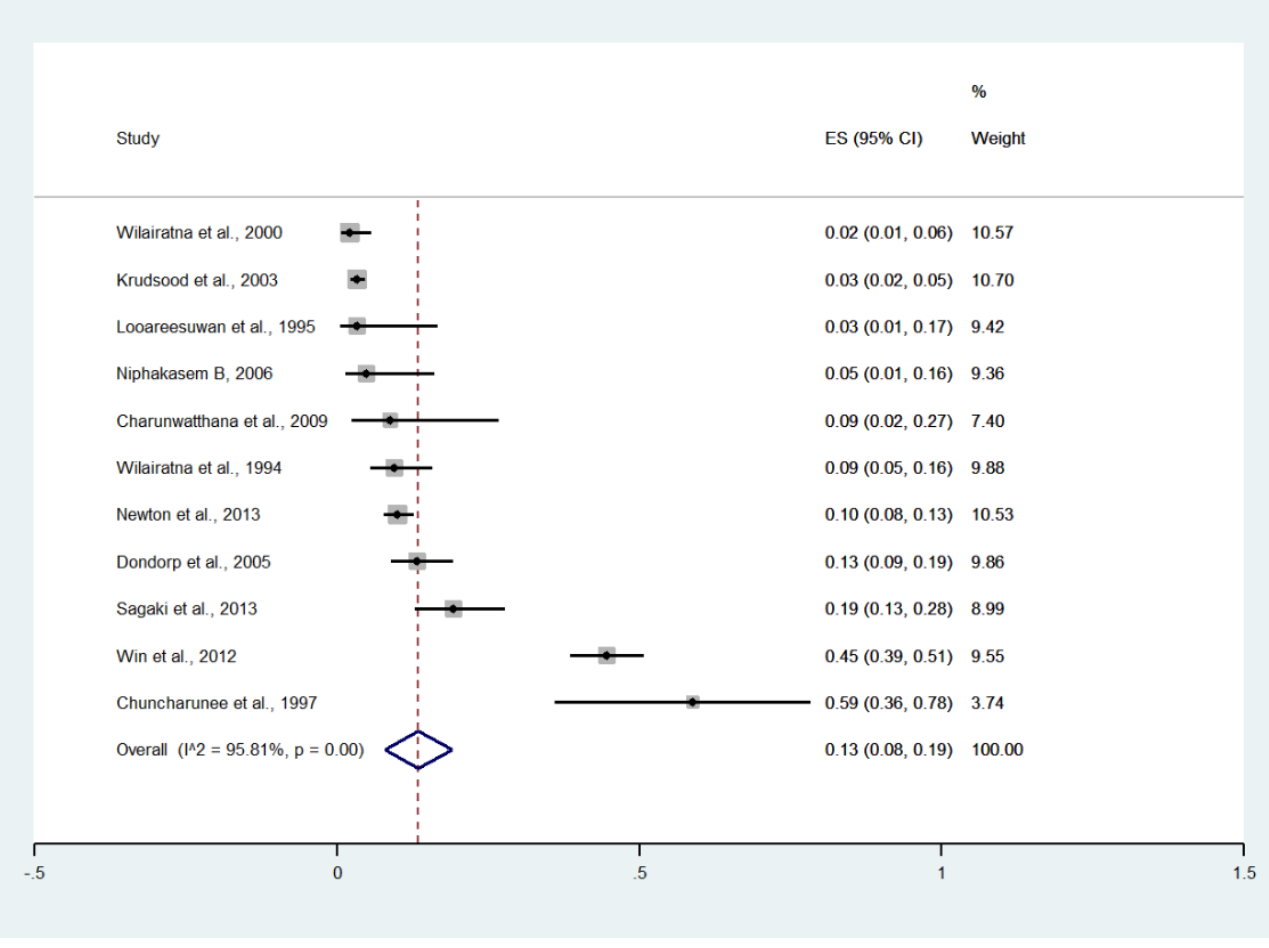
Figure 9. The pooled prevalence of renal impairment among patients with severe malaria in Thailand. The label for the x-axis is the scale of estimated prevalence. Abbreviations; ES, estimated prevalence; CI, confidence interval .